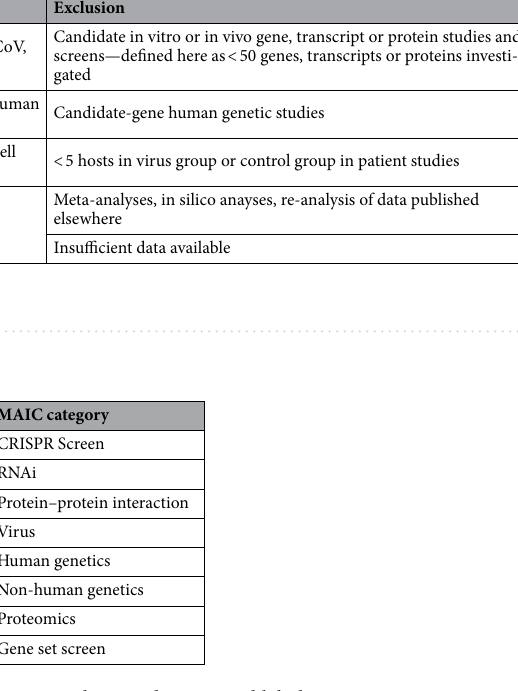
Table 2. Methodologies accepted for inclusion in meta-analysis and associated labels.